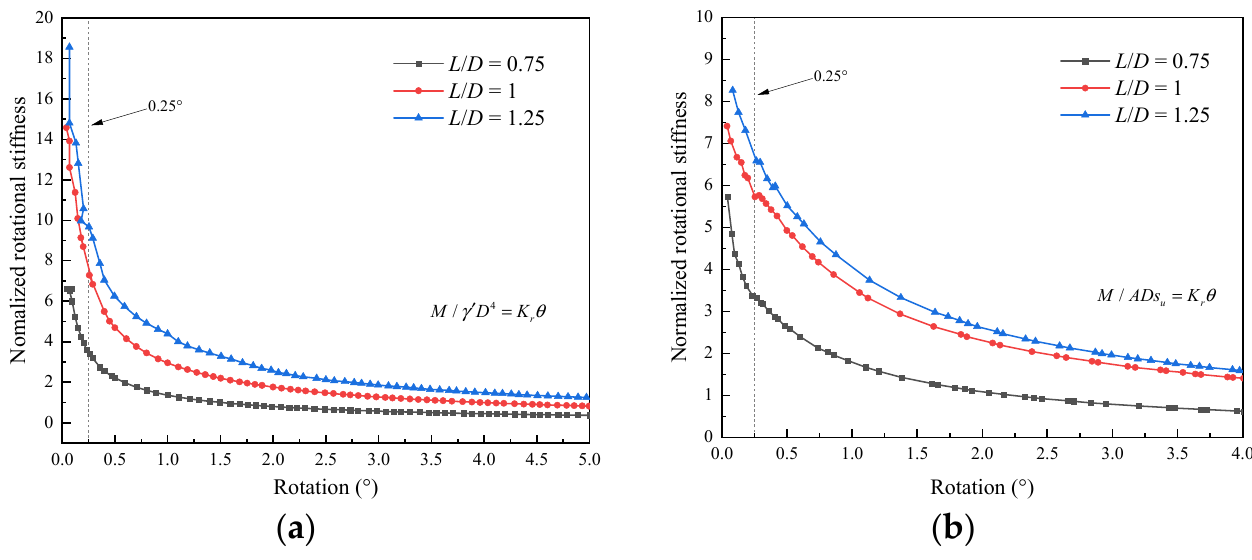
Figure 21. Degradation of normalized rotational sti ff ness with rotation: ( a ) sand, ( b ) soft clay.